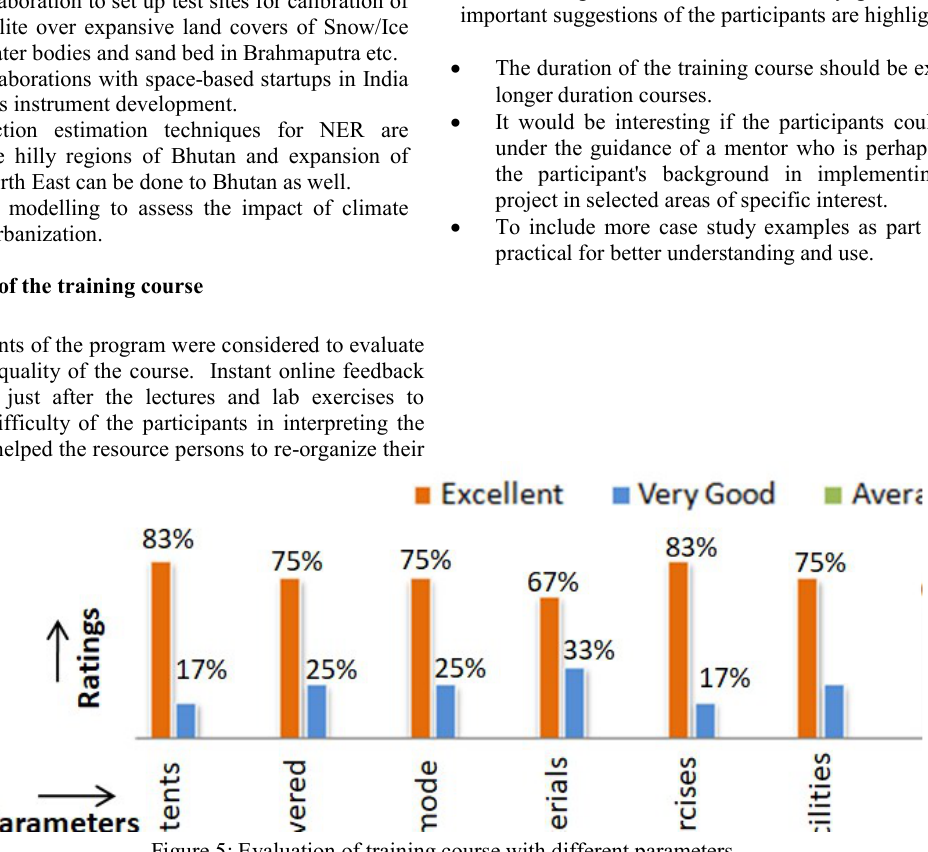
Figure 5: Evaluation of training course with different